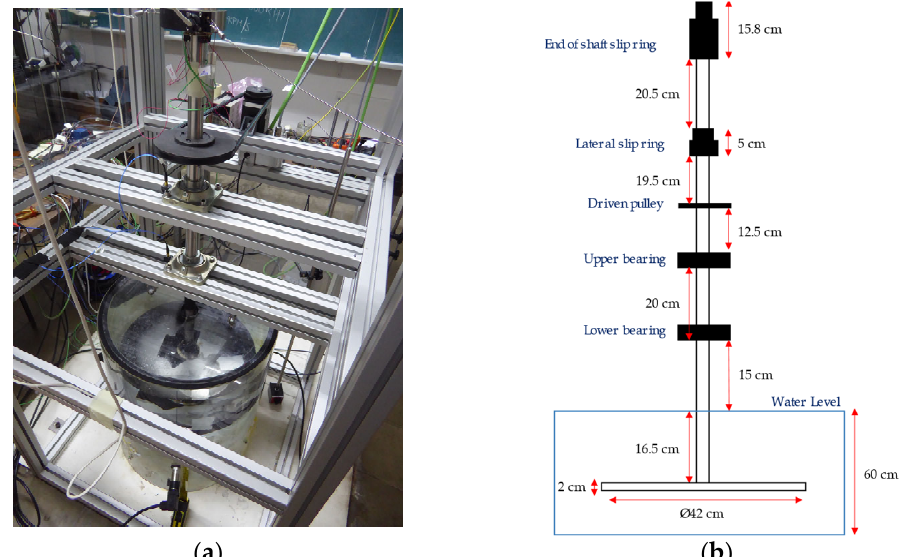
Figure 1. ( a ) The test rig mounted in the laboratory. ( b ) Geometry and dimensions of the test rig. As Figure 1b shows, the shaft was equipped with two slip rings: one mounted at the top of the shaft and the other one in the middle of the shaft. The slip ring at the top of the shaft, indicated in Figure 2a as the “end of shaft slip ring”, had 20 circuit connections (Slip Ring, SR20M, Michsci), and it was used to transmit the signals of several strain gauges located on board to the data acquisition system placed off board. The slip ring in the middle of the shaft, indicated in Figure 2b as the “lateral slip ring”, had six circuit connections (Slip Ring, B6-2, Michsci), and it was used to transmit the signal of an accelerometer located on board to the data acquisition system and to feed a piezoelectric PZT patch located on board with a signal from the data acquisition